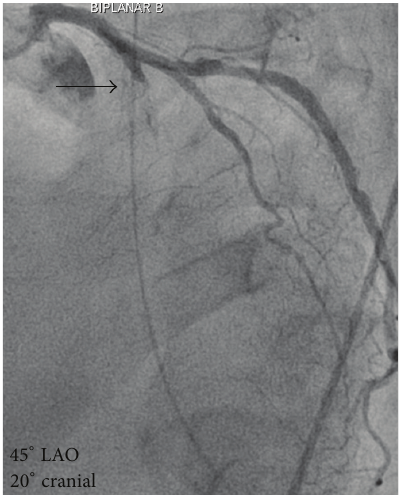
Figure 6: Coronary angiography revealing a complete occlusion of the left anterior descending coronary artery marked with the black